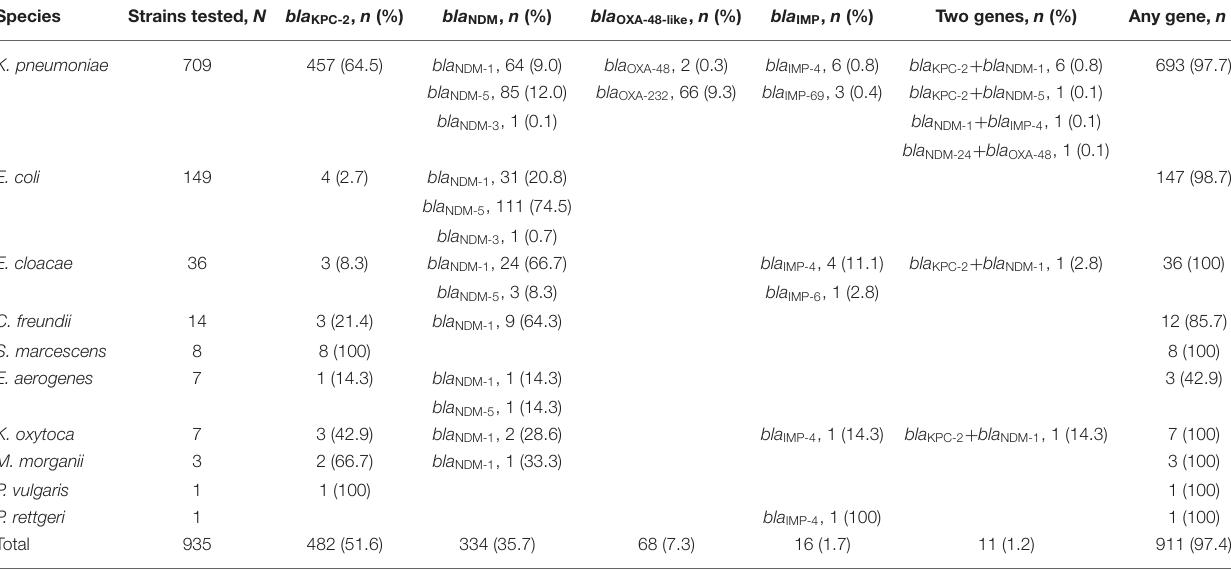
TABLE 2 | Prevalence of different carbapenemase genes among 935 CRE strains. Species Strains tested, N bla KPC-2 , n (%)